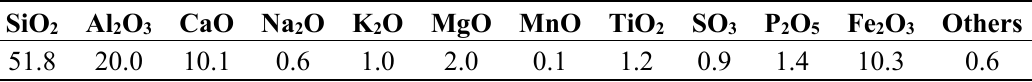
Table 1. Chemical composition (reported as oxide wt%) of fly